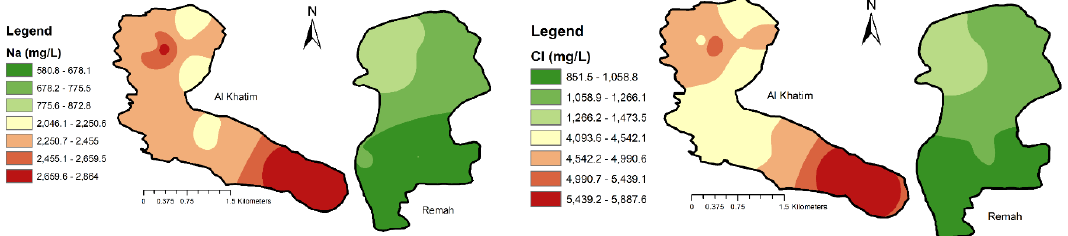
+ ), and chloride (Cl − )